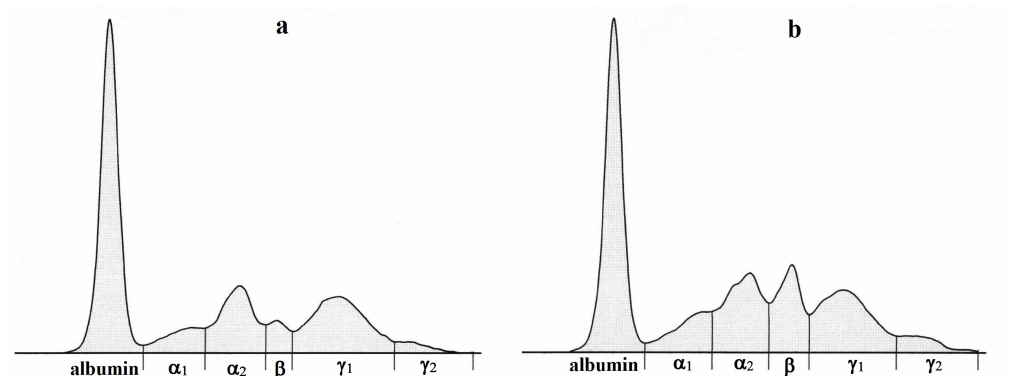
Figure 4. Example of the electrophoretic separation of serum proteins using agarose gel electrophoresis in a sheep during the perioperative period: ( 1 ) before surgical intervention; ( 2 ) day 7; ( 3 ) day 14; ( 4 ) day 30 after